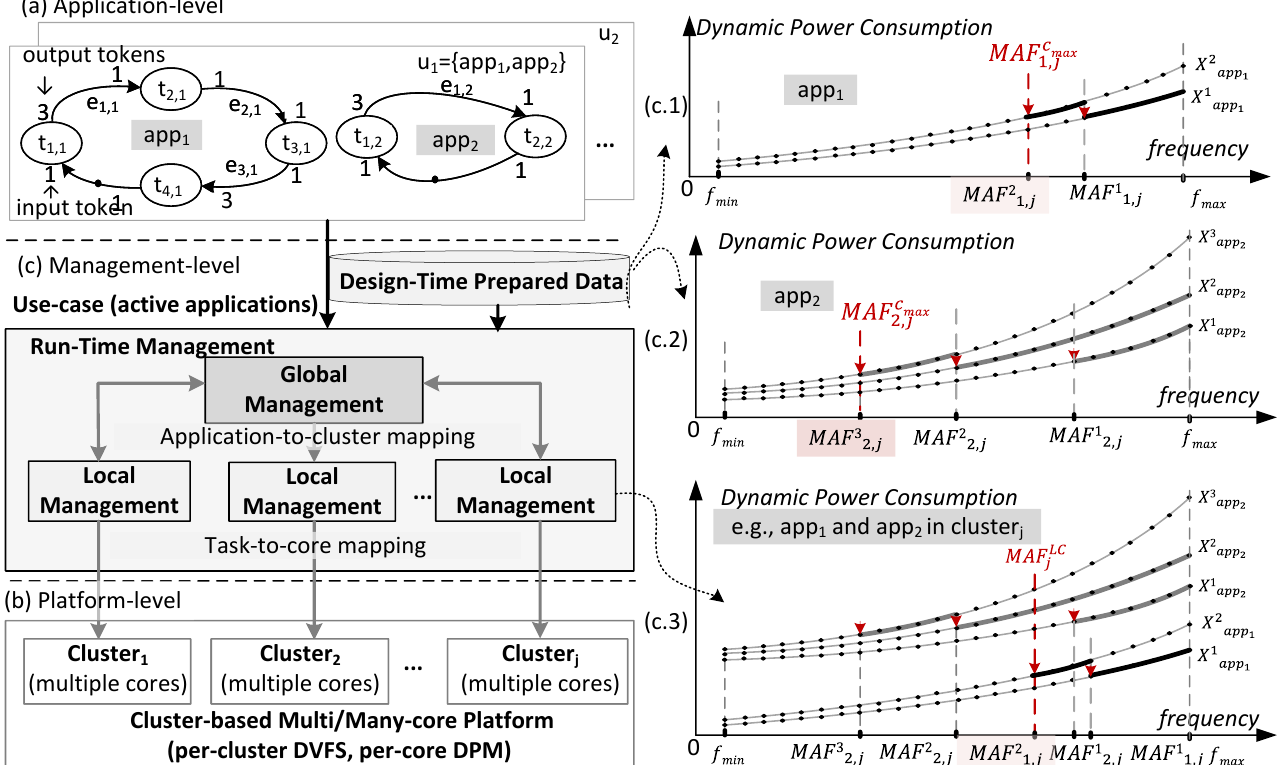
Figure 1. HHMS in [11] with three abstraction levels. ( a ) At the application level, a use case is composed of multiple concurrently executing applications. ( b ) At the platform level, a cluster-based multi/many-core system supporting per-cluster DVFS and per-core DPM. ( c ) At the management level, a hybrid hierarchical management structure consists of global and local management, and the run-time management is based on design-time prepared data. ( c.1 , c.2 ) Design-time-prepared data (prepared mappings and corresponding MAFs) for app 1 and app 2 . ( c.3 ) The consideration